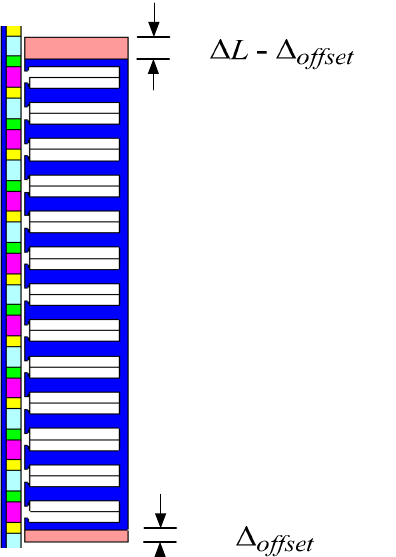
Figure 7. Initial phase adjustment of the end-effect cogging force by offsetting the auxiliary core.